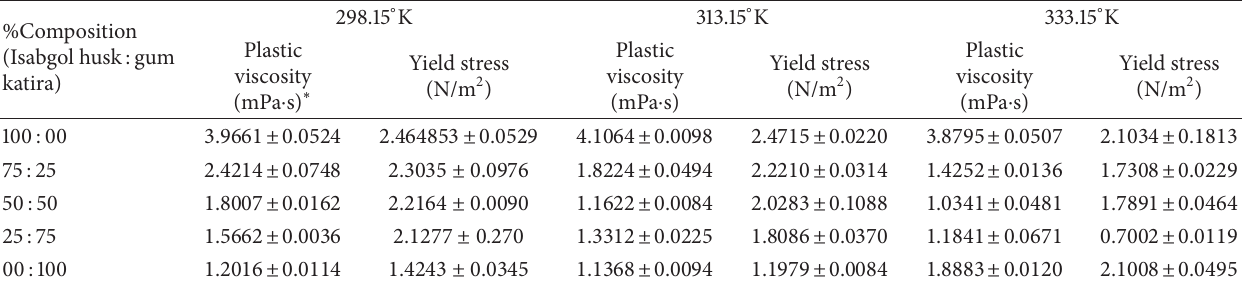
Table 4: Plastic viscosity and yield stress data of 1:1 mass% blends calculated from Casson equation.